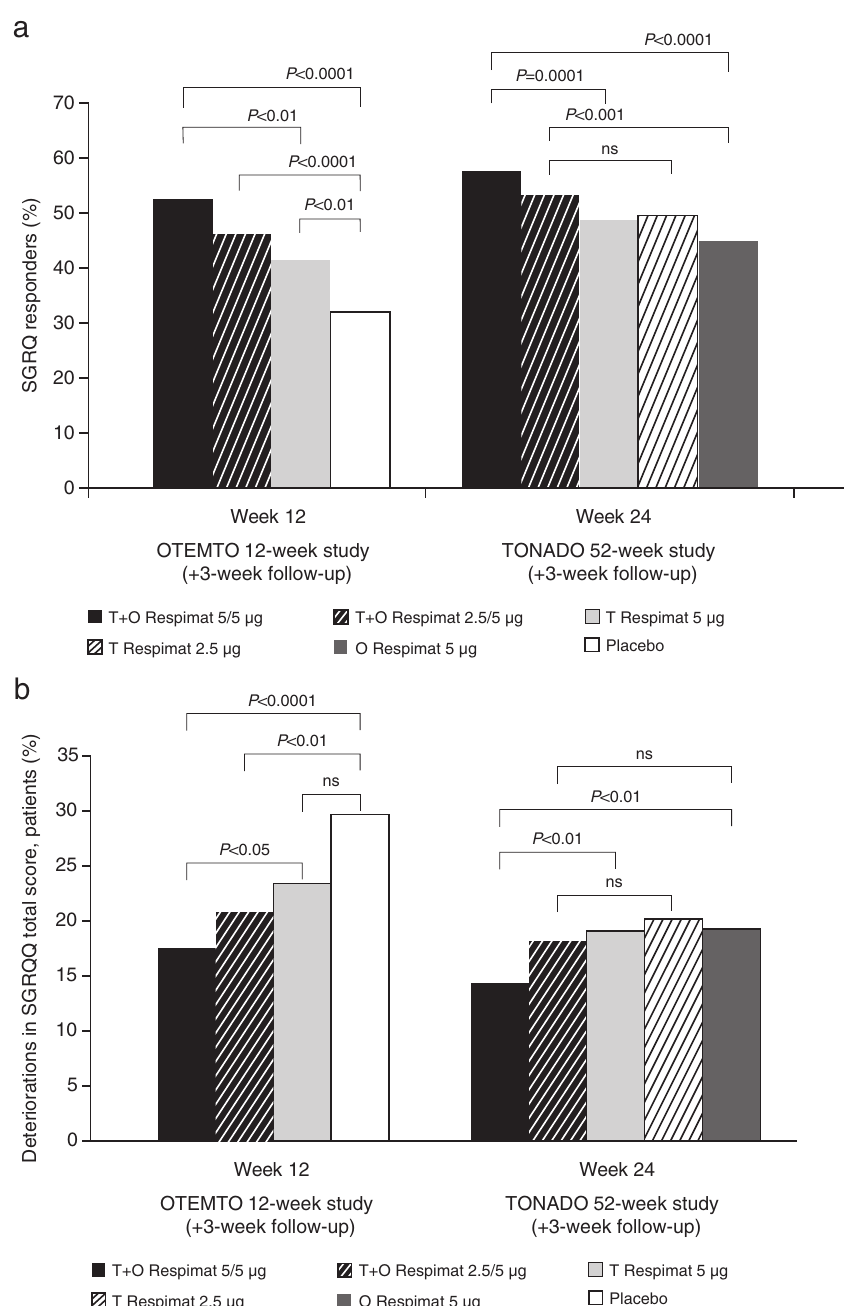
Fig. 3 SGRQ responders ( a ) and deteriorators ( b ) after 12 weeks of treatment (OTEMTO) or 24 weeks of treatment (TONADO). ns, not signi fi cant; O, olodaterol; SGRQ, St George ’ s Respiratory Questionnaire; T,